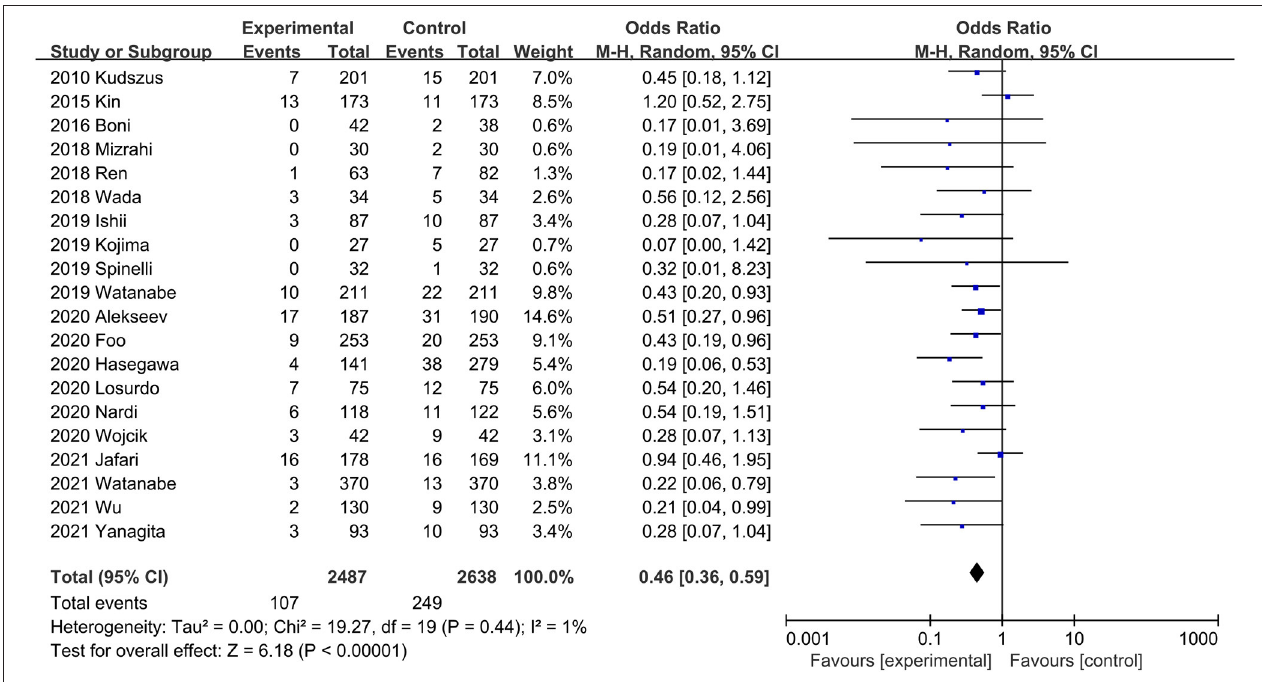
FIGURE 3 | Effect of indocyanine green on anastomotic leakage